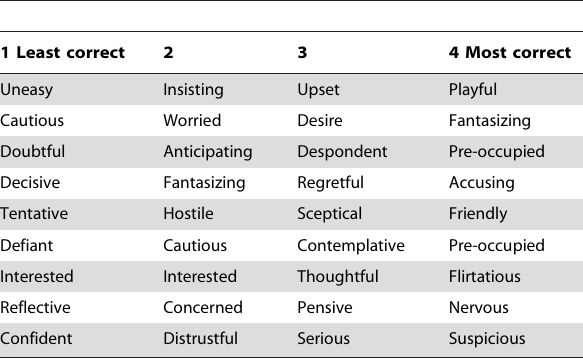
Table 5. Correct responses to Eyes items in quartiles depending on how often they are correctly